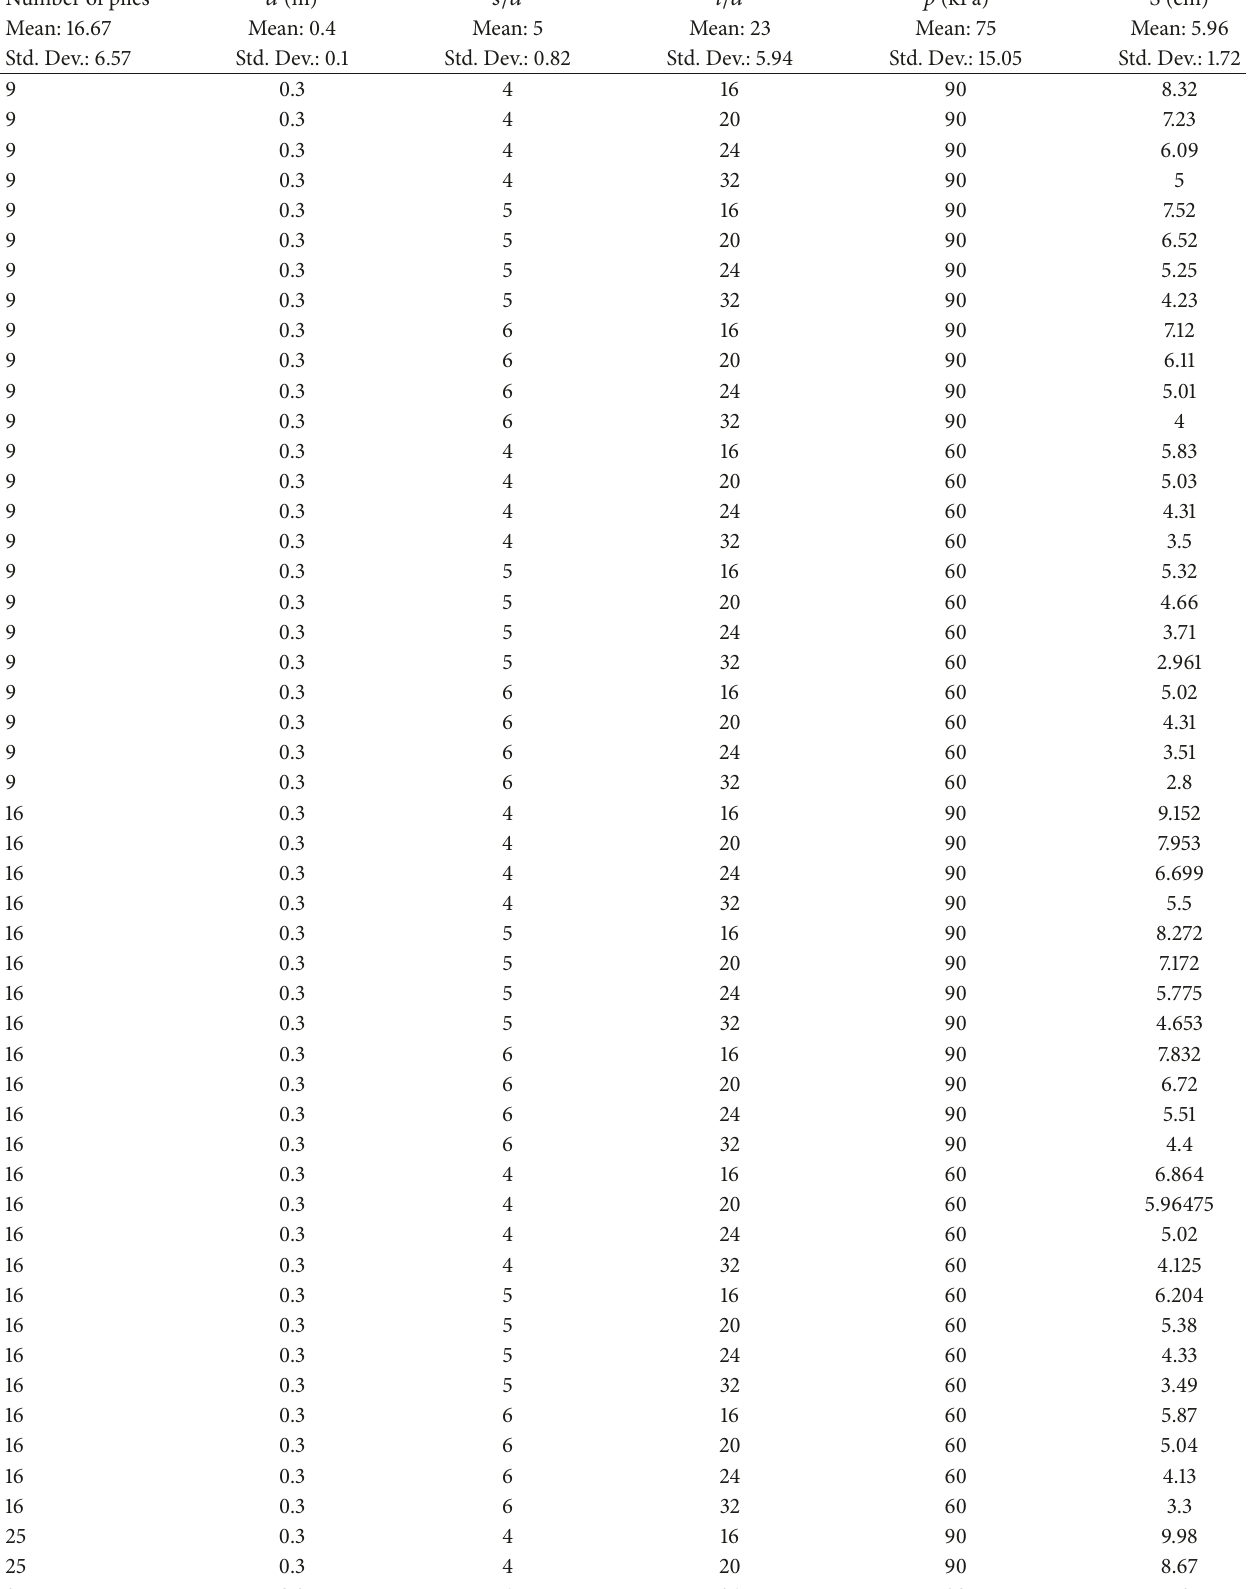
Table 1: Parametric study on the whole affecting parameters for static loading